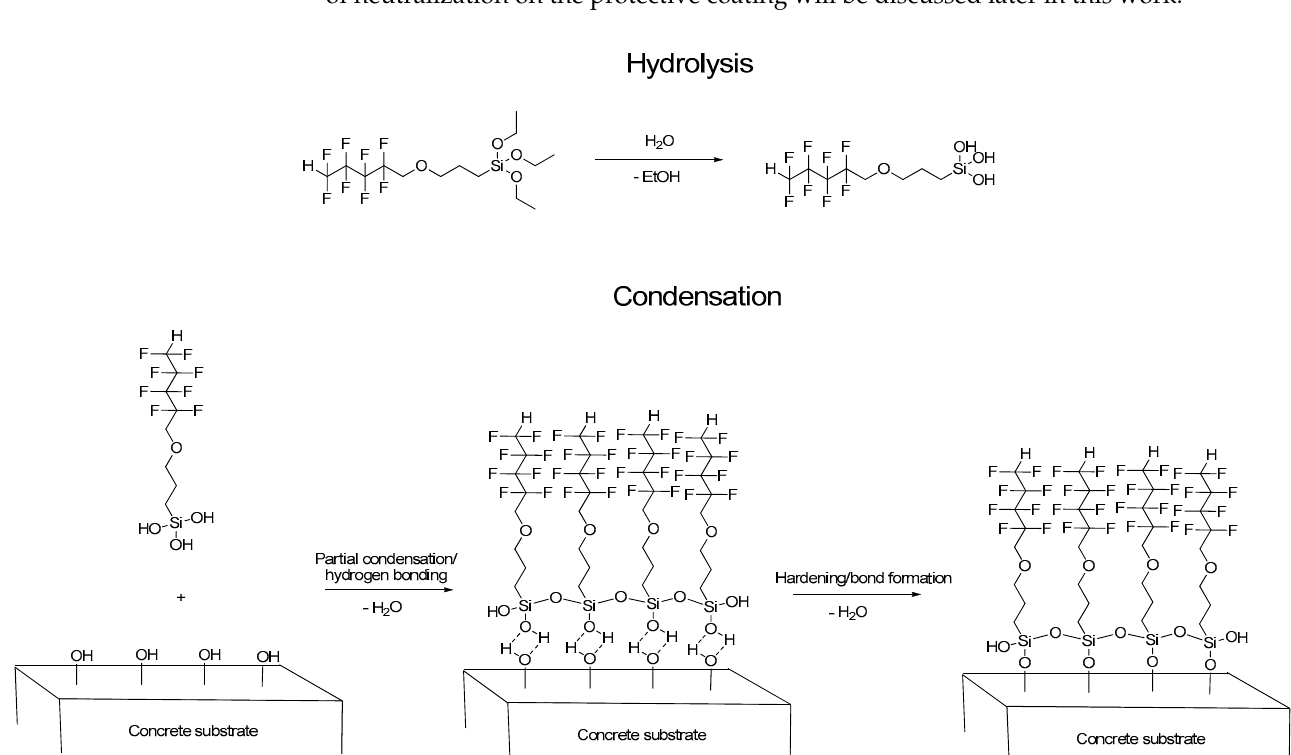
Figure 1. The sol-gel reaction mechanism between OFTES and the concrete surface.